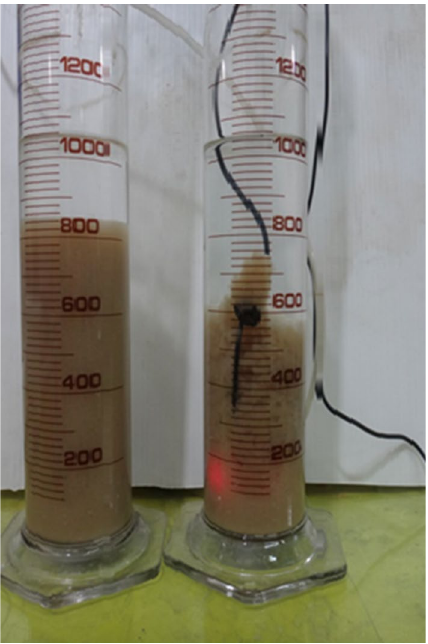
Fig. 7 Effect of 1.7-MHz ultrasound irradiation on sludge volume in comparison with the condition without sonication at MLSS of 6000 mg/L and 30